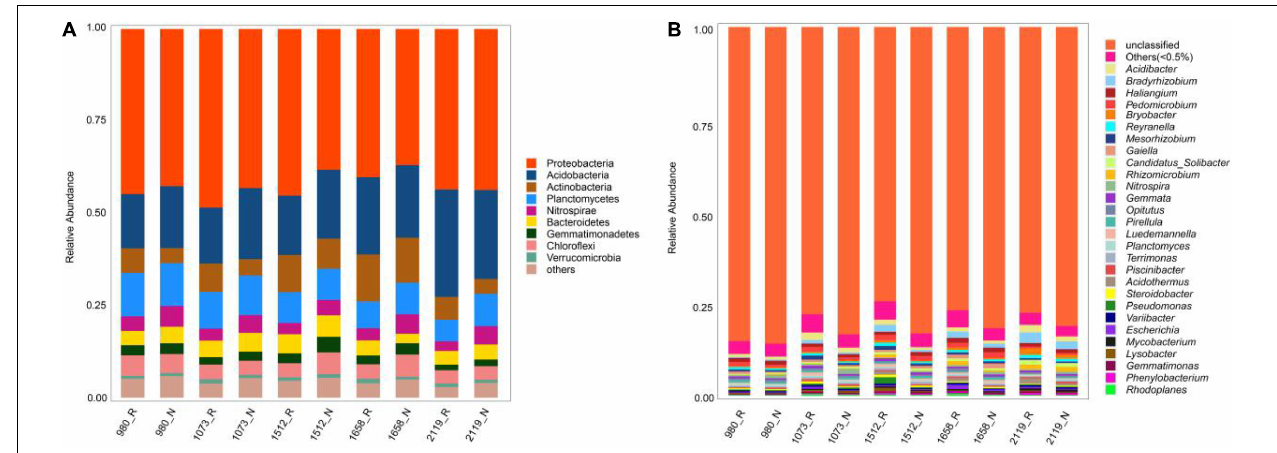
FIGURE 1 | Relative abundance of rhizosphere and non-rhizosphere bacteria across whole elevations. Barplots showing the bacterial community composition at phylum (A) and genus (B) levels. R and N indicate rhizosphere and bulk soil samples, respectively.